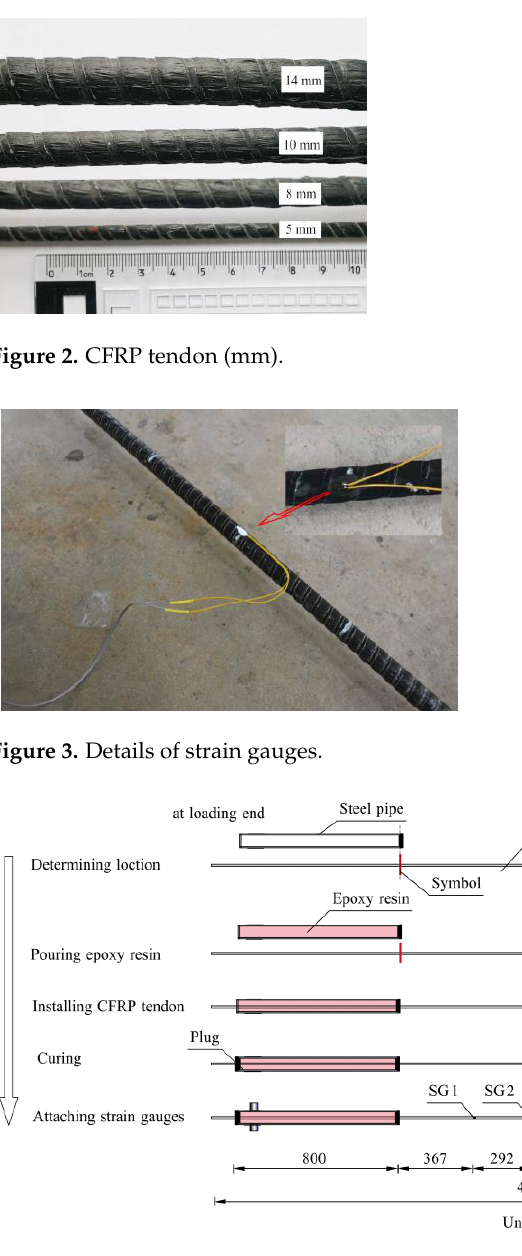
Figure 4. The preparation process of specimens (mm).